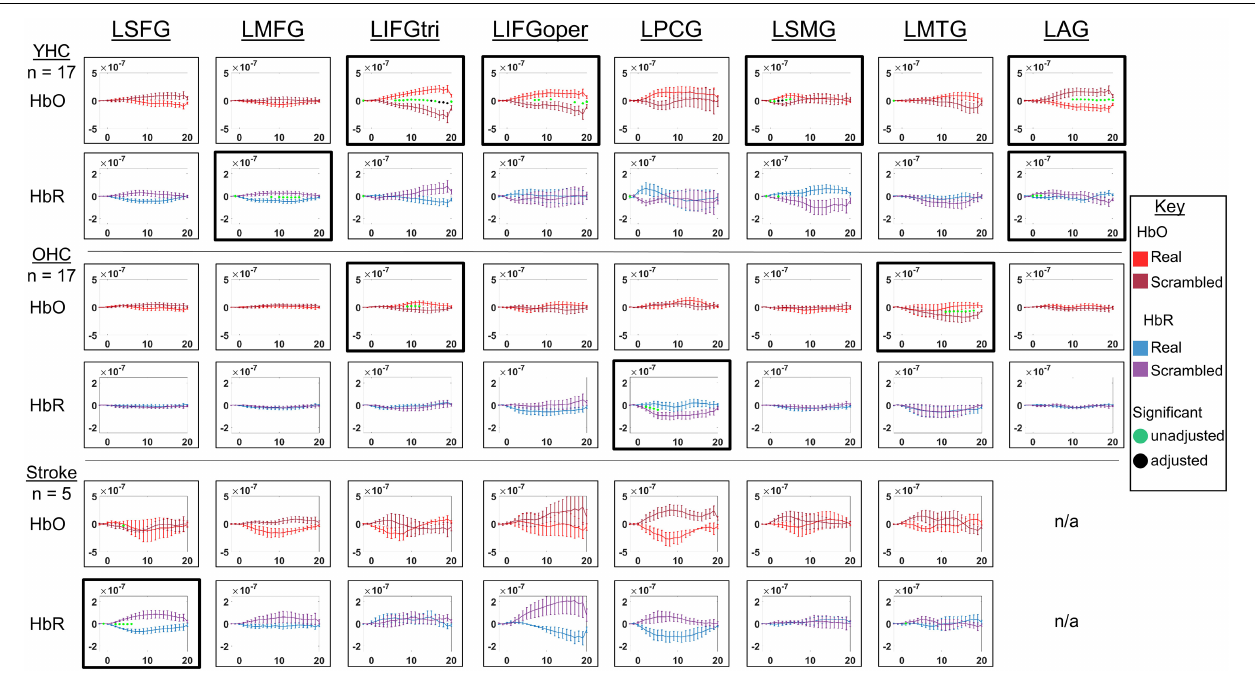
FIGURE 7 | Comparison of group average HRF between task conditions for left hemisphere ROIs during picture naming. HbO and HbR changes in µ M units. Significant difference between task conditions at p < 0.05 level are reflected by a green dot and after FDR-adjustment with alpha of 0.05 by a black dot. Black borders denote ROIs for which there was a significant difference between the task conditions for at least three consecutive seconds. When the red line is higher than the maroon line, it suggests there was greater HbO concentration change in the real than scrambled picture condition. When the blue line is lower than the purple line, it suggests there was lower HbR concentration change in the real than scrambled picture condition. Both patterns are consistent with greater neural activation (i.e., increase in oxygenated blood, decrease in deoxygenated blood) in the real than scrambled picture condition and vice versa. LSFG, left superior frontal gyrus; LMFG, left middle frontal gyrus; LIFGtri, left inferior frontal gyrus pars triangularis; LIFGoper, left inferior frontal gyrus pars opercularis; LPCG, left precentral gyrus; LSMG, left supramarginal gyrus; LAG, left angular gyrus; YHC, younger healthy controls; OHC, older healthy controls; HbO, oxygenated hemoglobin concentration change; HbR, deoxygenated hemoglobin concentration change; N/A, not available due to combination of pruned channels due to poor SNR and